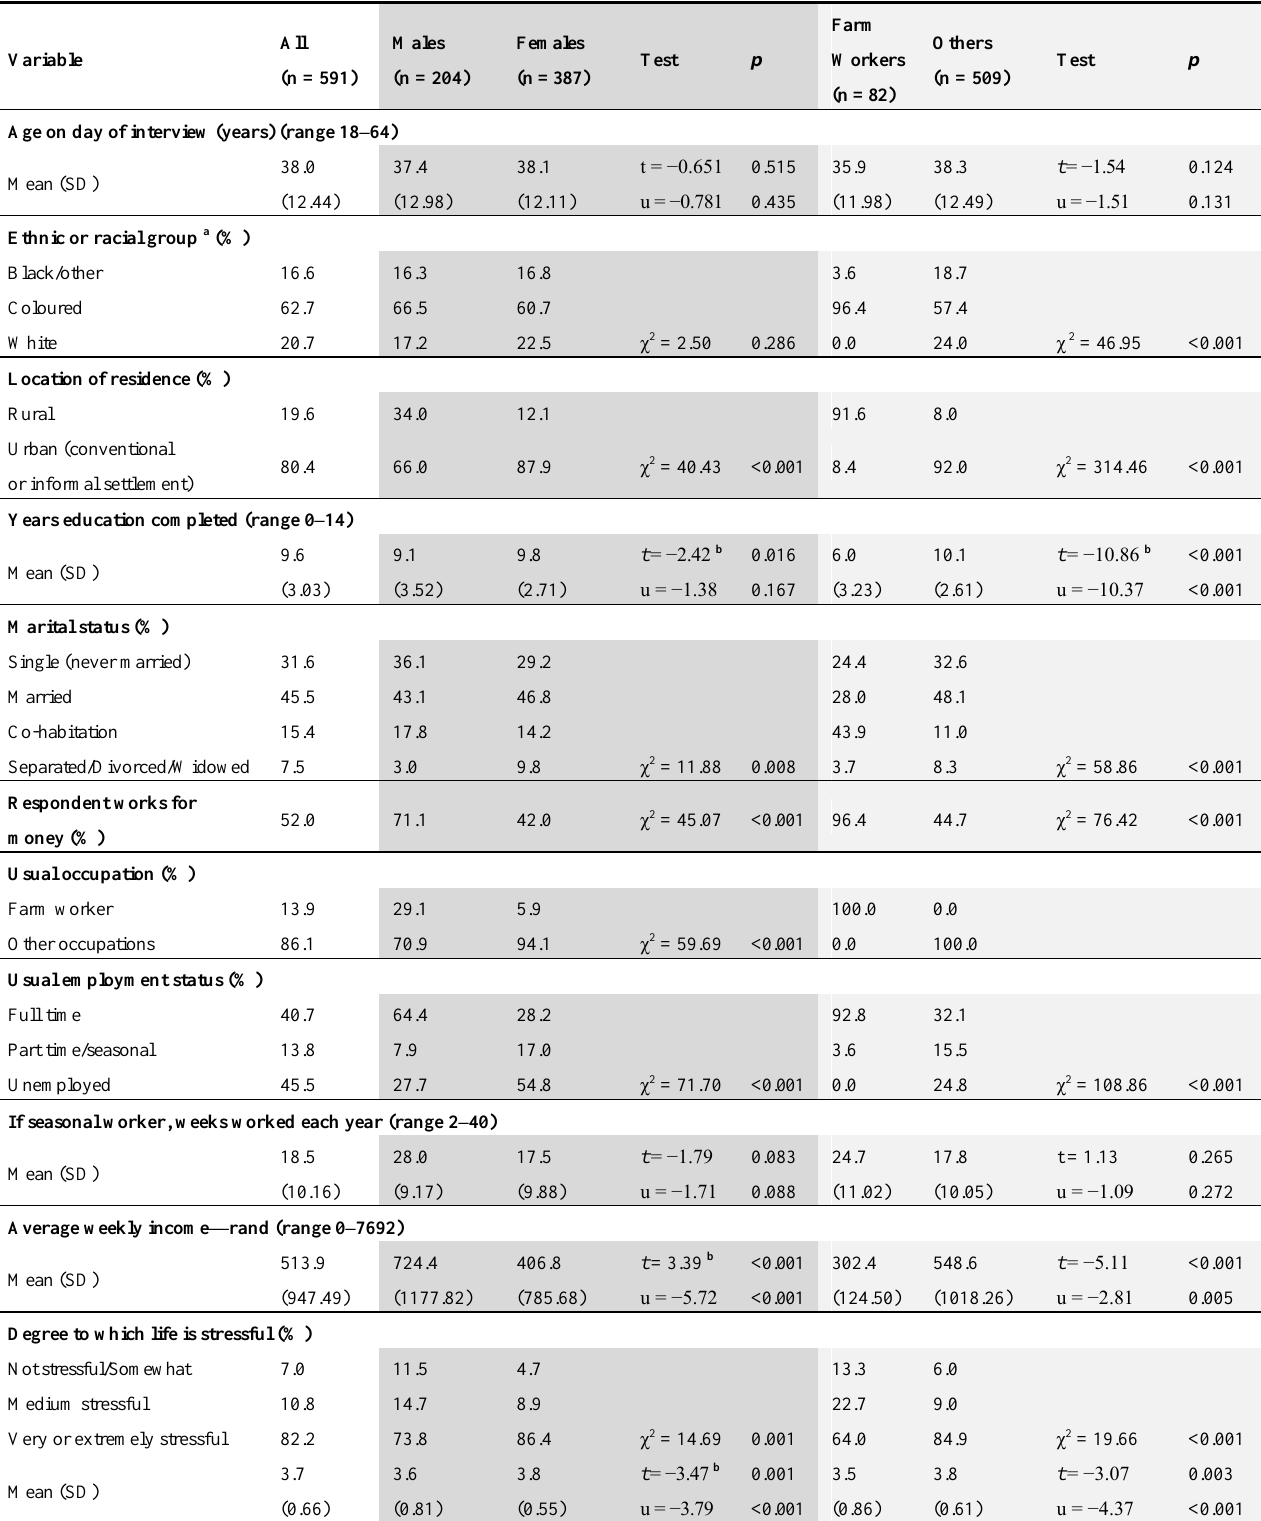
Table 1. Demographics and stress by gender and occupation, Western Cape Province, South Africa: